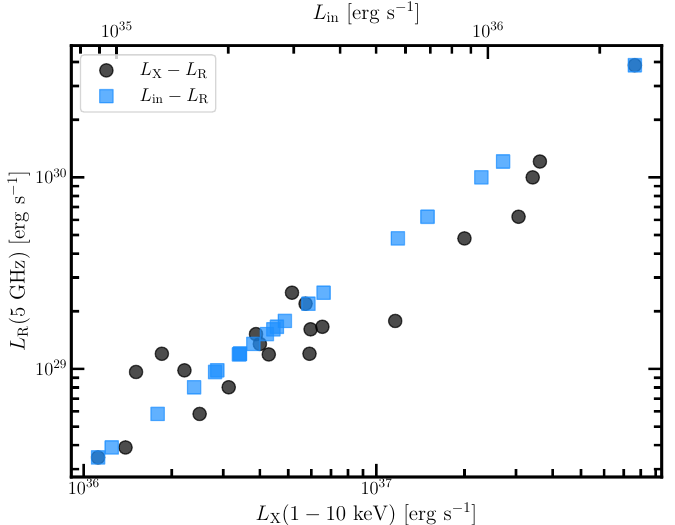
Figure 6. Radio/X-ray correlation for the ‘outlier’ track of MAXI J1348-630 (in the upper x-axis, the inner-disk luminosity is L in ). The black circles represent the observed radio/X-ray correlation, while the blue squares represent the radio/inner-disk